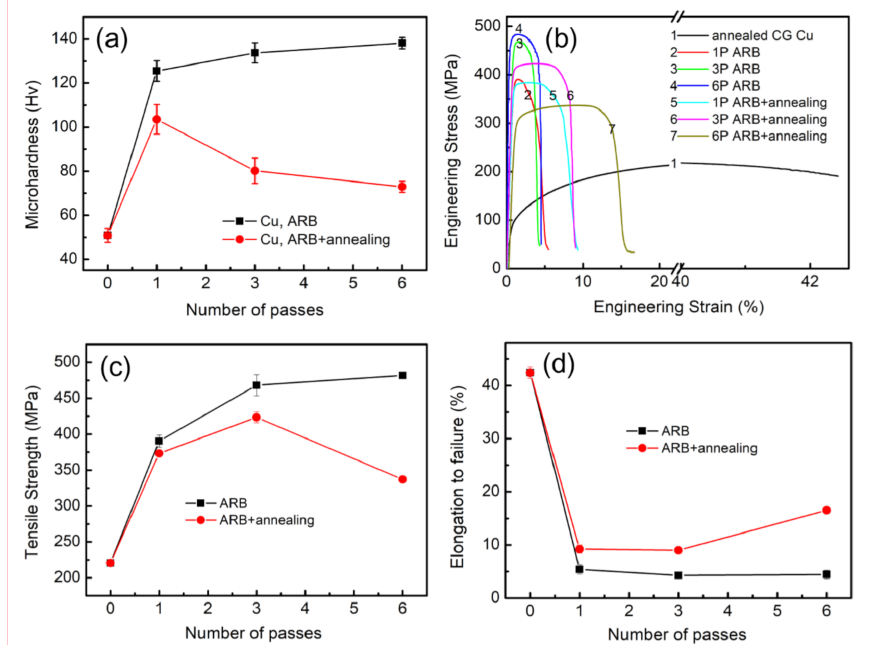
Figure 8. Microhardness ( a ), engineering stress–strain curves ( b ), tensile strength ( c ), and elongation to failure ( d ) of as-ARBed and as-annealed